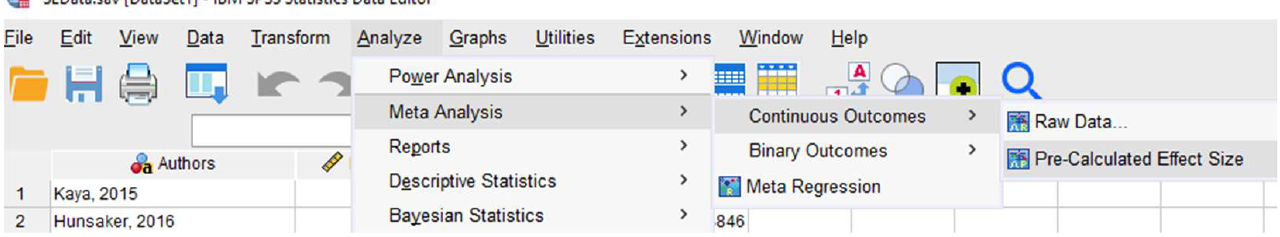
Figure 2. SPSS Meta Analysis Menu .